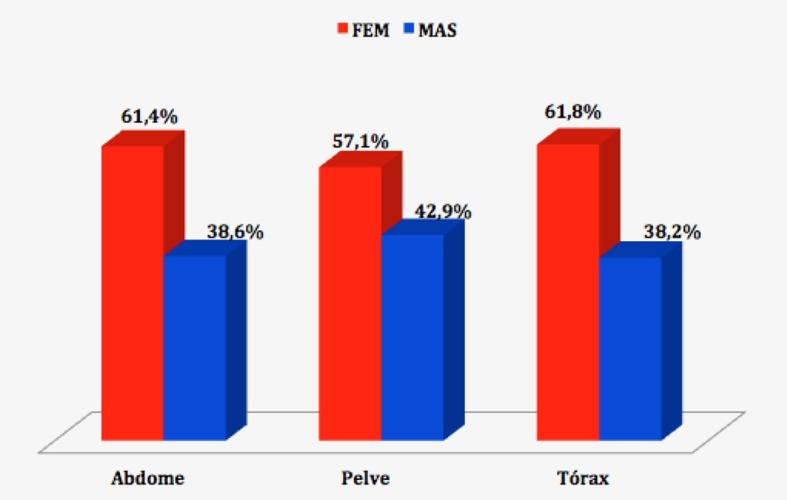
Distribuição quanto à topografia do exame e ao gênero dos pacientes.